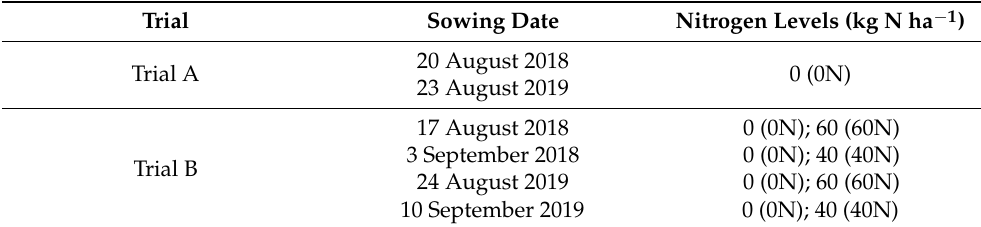
Table 2. Trial design, sowing dates, and N-level in Trials A and